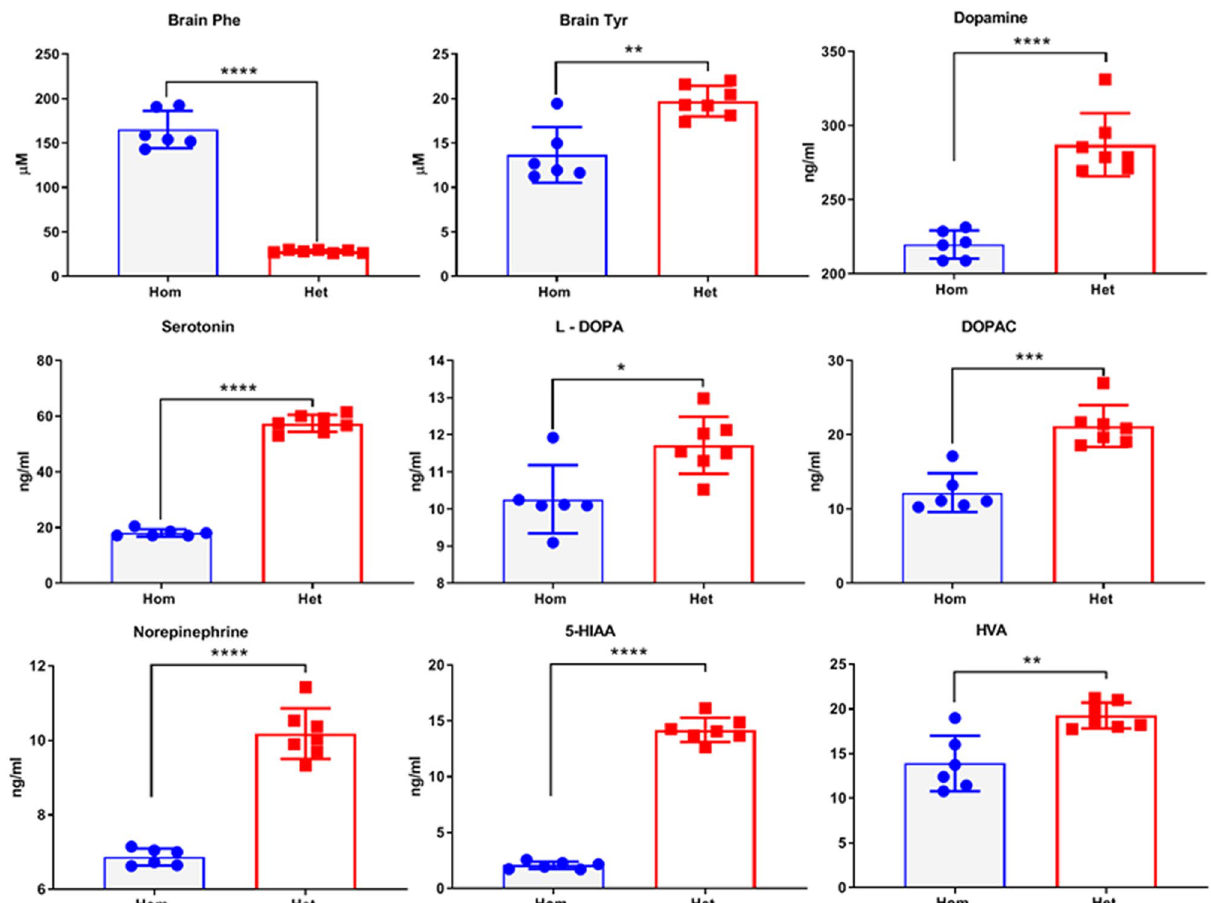
Figure 4. Analysis of Phe, Tyr and neurotransmitters in brains of Hom and Het Pah -KO mice at 6 months. Scatter plot charts show brain Phe, Tyr, serotonin, dopamine, L-DOPA, DOPAC, NE, 5-HIAA, and HVA. n = 6 Hom, 7 Het. Bars indicate group mean and the error bars indicate standard deviation (* p = 0.01, ** p = 0.003— 0.007, *** p = 0.0001, **** p <